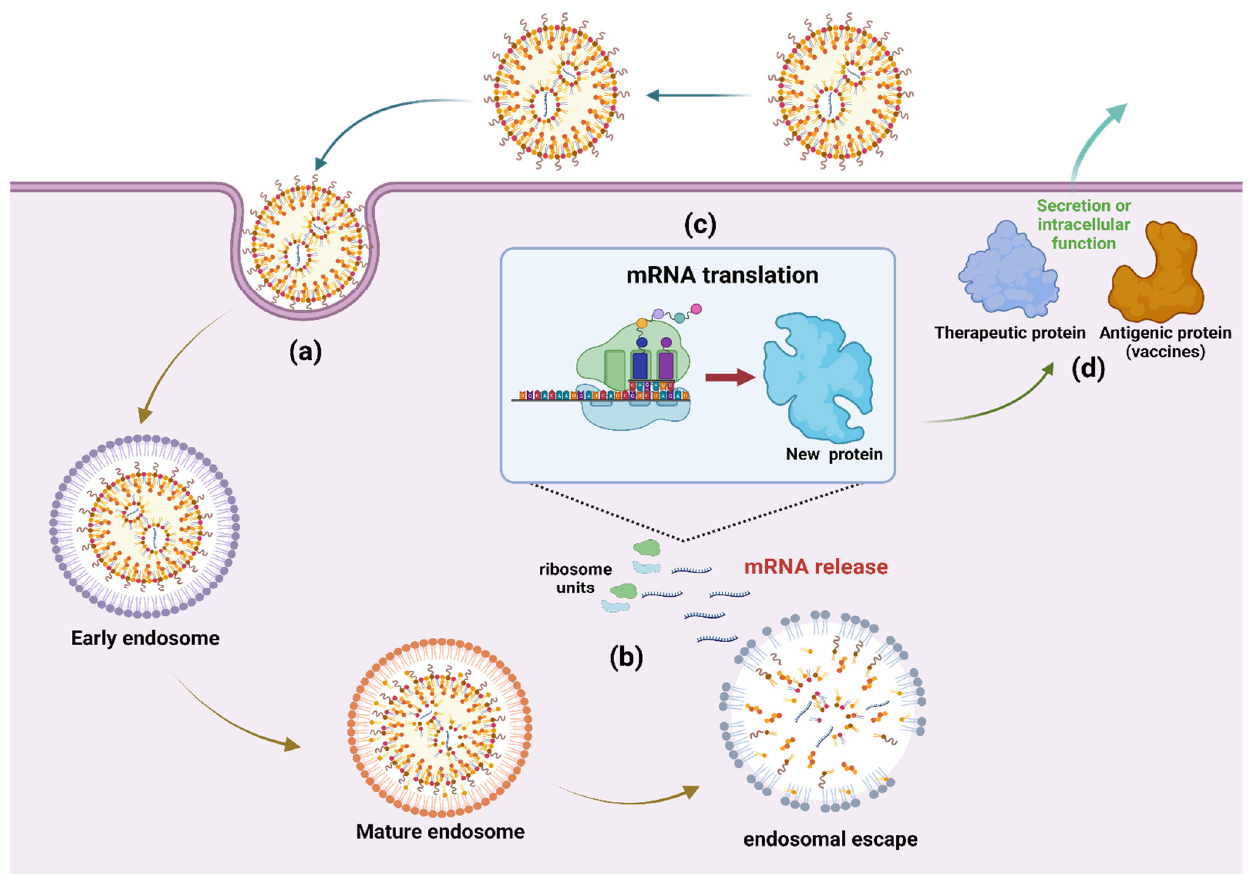
Figure 2. Cellular uptake and expression of LNP-encapsulated mRNA constructs. Constructs encoding antigenic/therapeutic proteins are encapsulated in LNP to prevent degradation and to promote cellular uptake: ( a ) Uptake of the mRNA-LNP complex is mediated by endocytosis; ( b ) mRNA constructs are released from the endosome into the cytosol where they are translated by ribosomes; ( c ) the antigenic/therapeutic proteins are produced; ( d ) The protein products are sequestered intracellularly, incorporated into cell membranes or secreted. Figure was created with biorender.com (accessed on 19 August 2022).